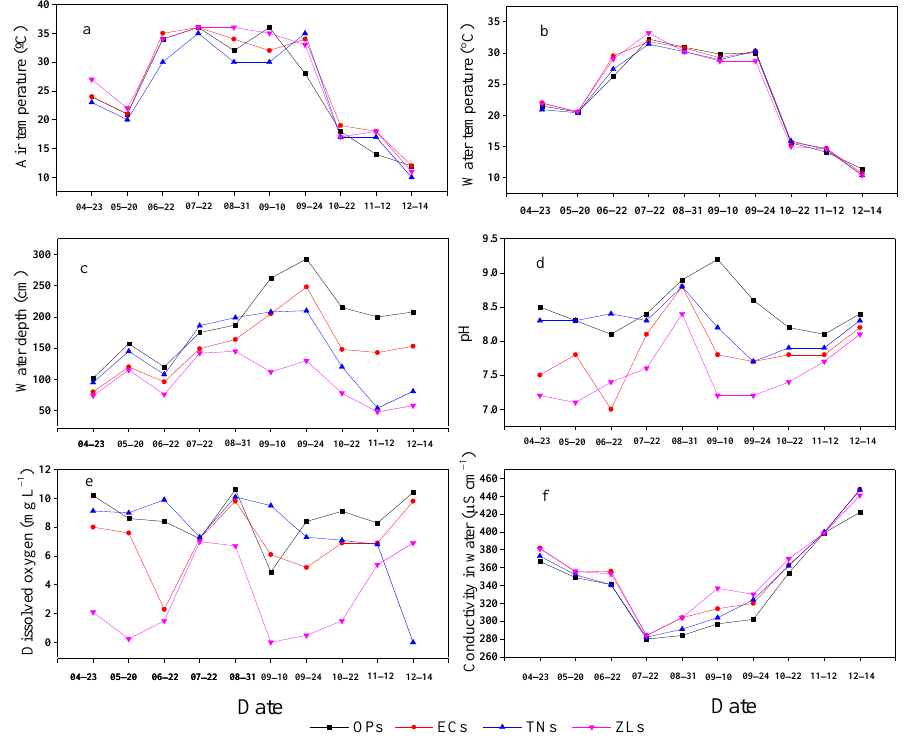
Figure 3. The spatial dynamics of environmental factors, including ( a ) air temperature, ( b ) water temperature, ( c ) water depth, ( d ) pH, ( e ) dissolved oxygen concentration and ( f ) water conductivity in the four community study zones. Table 1. The physicochemical characteristics at the four sites.